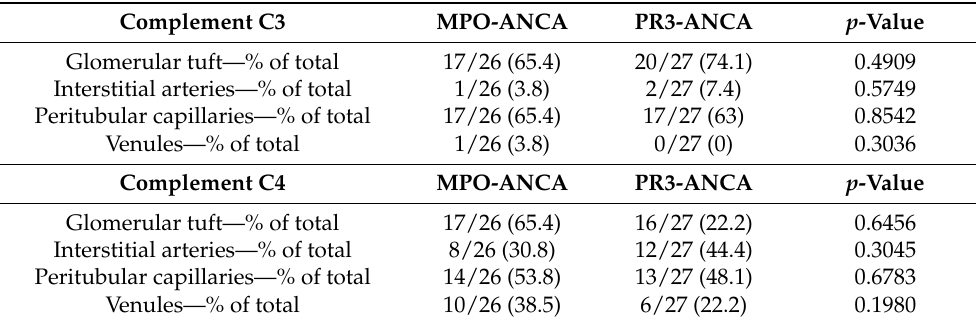
Figure 3. CRP elevation is correlated with complement C4 deposits in interstitial arteries in MPO-ANCA-associated renal vasculitis: ( A ) Immunostainings for intrarenal complement C3 and C4 deposits, with insets; positive glomeruli (G) are indicated (scale bars: 500 µm). ( B ) Correlations between CRP levels, serum C3 and C4 measurements, and intrarenal complement C3 and C4 deposits localized to different vascular compartments in ANCA-associated renal vasculitis, as shown by heatmaps reflecting the mean values of Spearman’s ρ; circle size represents the significance level. ( C ) CRP levels after group separations according to ANCA subtypes. Group comparisons were performed with the Mann–Whitney U-test (n.s. = not significant). ( D ) Representative immunostaining for intrarenal complement C4 deposits in interstitial arteries in the subgroup with MPO-ANCA seropositivity; arrowheads indicate endothelial cells positive for complement C4 (scale bar: 25 µm). Abbreviations: ANCA, anti-neutrophil cytoplasmic antibody; CRP, C-reactive protein; G, glomerulus; MPO, myeloperoxidase; PR3, proteinase 3. Table 3. Complement C3 and C4 deposits in ANCA-associated renal vasculitis separated by MPO- ANCA and PR3-ANCA